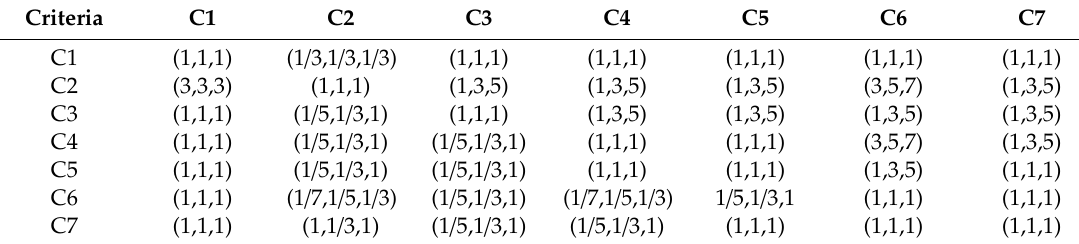
Table 3. Fuzzy evaluation matrix.